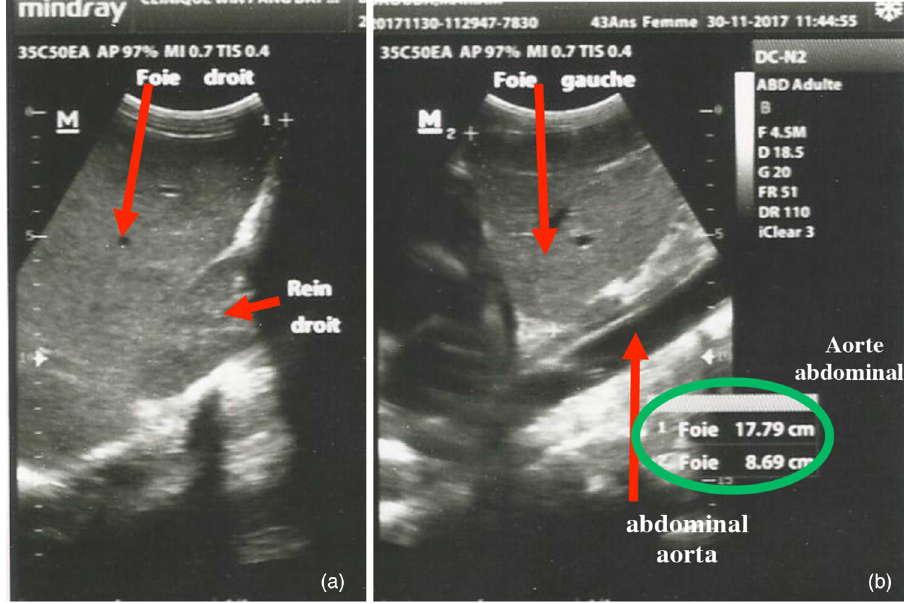
Fig. 3. a: Longitudinal section of the right hypochondrium passing through the liver in renal axis. b: Longitudinal section passing the liver in the abdominal aorta axis (hepatomegaly, measurement).